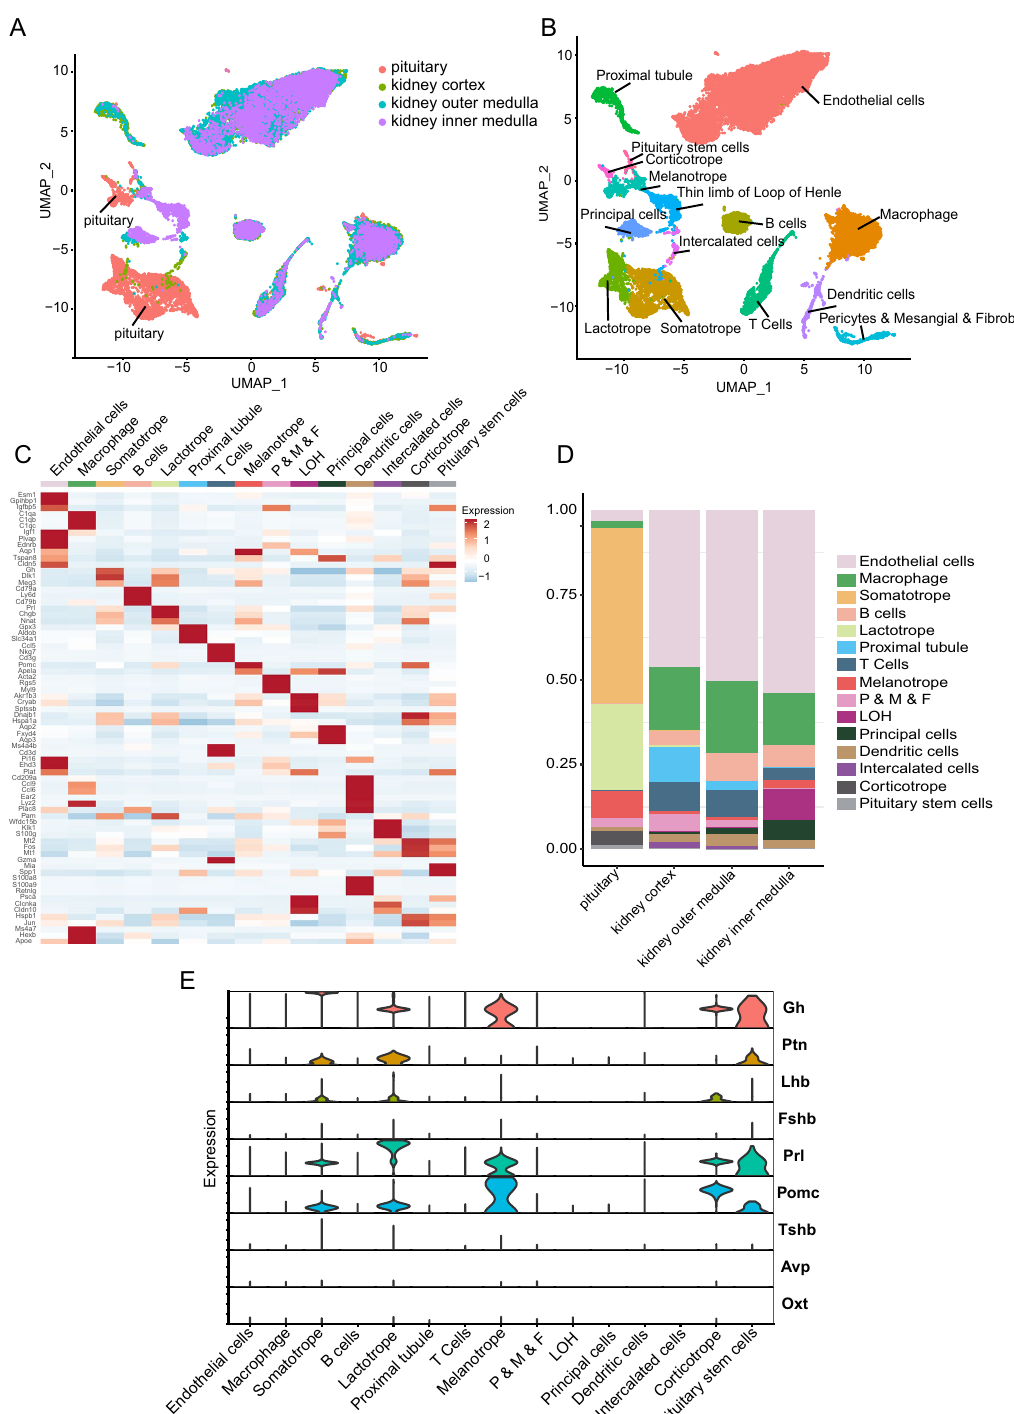
Figure 1. Combination of the pituitary and kidney single-cell transcriptomic data. ( A ) UMAP of the sample distribution in cell clusters based on a combination of pituitary and kidney single-cell transcriptomic data. ( B ) Cell cluster annotations of the combined pituitary and kidney single-cell transcriptomic data. ( C ) Heatmap of top three highest expressed genes of each cell type. ( D ) Bar plot of the percentage of cell types in each sample. ( E ) Expression of classical hormones of the